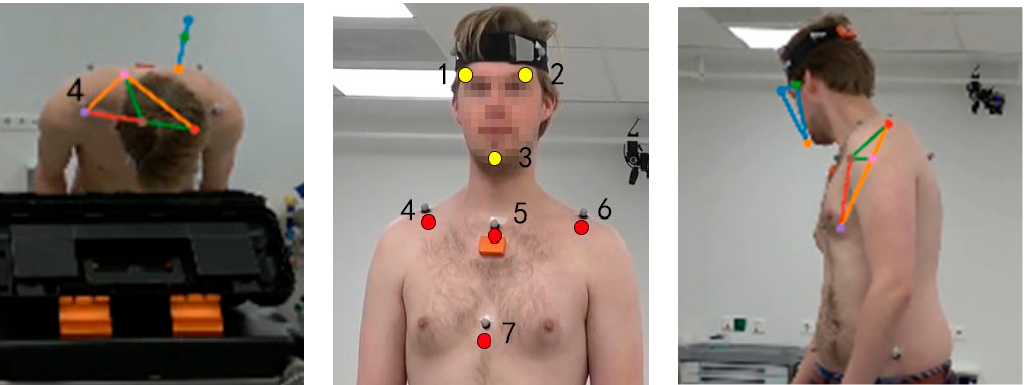
Figure 11. Example of tracking points bad detection. In the left figure, only tracking point 4 was tracked correctly, in the right figure, no tracking points were tracked correctly.